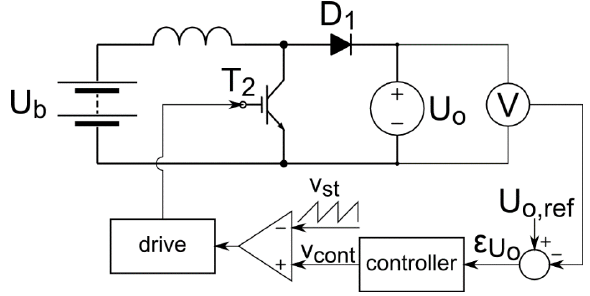
Figure 9. Outline of the feedback voltage control in discharge condition.